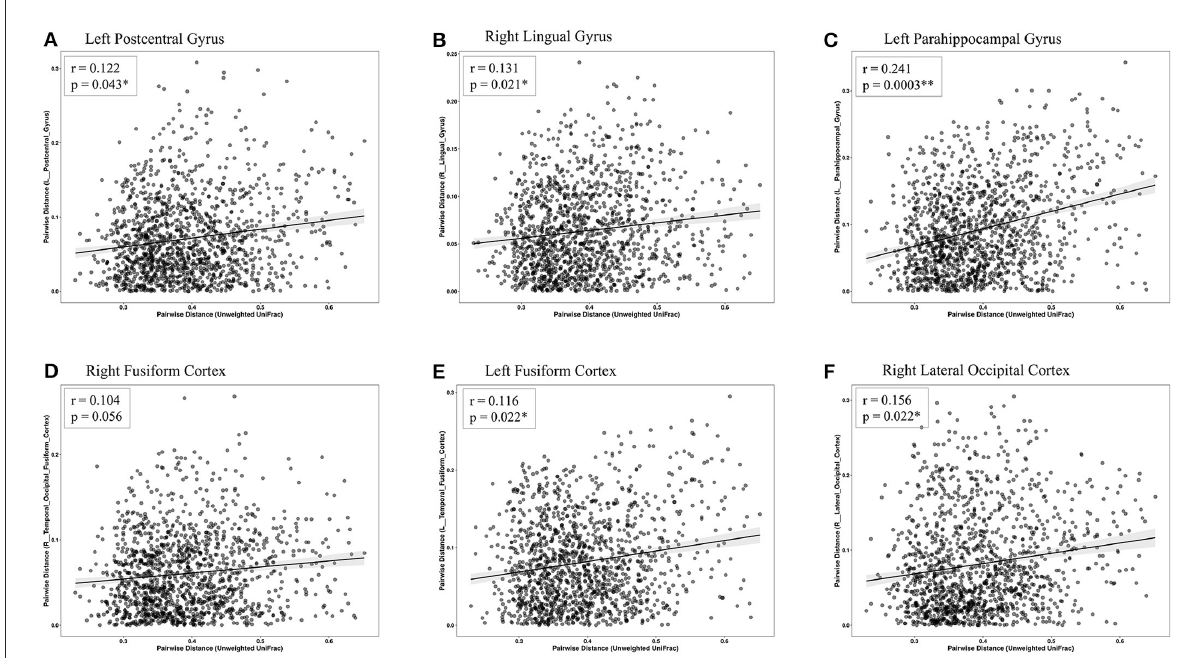
FIGURE6 Scatterplots of Euclidean distance. The associations between fecal microbiome β -diversity (Euclidean distance centered log-transformed counts) and the gray matter distance separating pairs of late-life depression (LLD) patients or healthy controls in the (A) left postcentral gyrus, (B) right lingual gyrus, (C) left parahippocampal gyrus, (D) right fusiform cortex, (E) left fusiform cortex, and (F) right lateral occipital cortex. Each point represents a pair of LLD patients or healthy